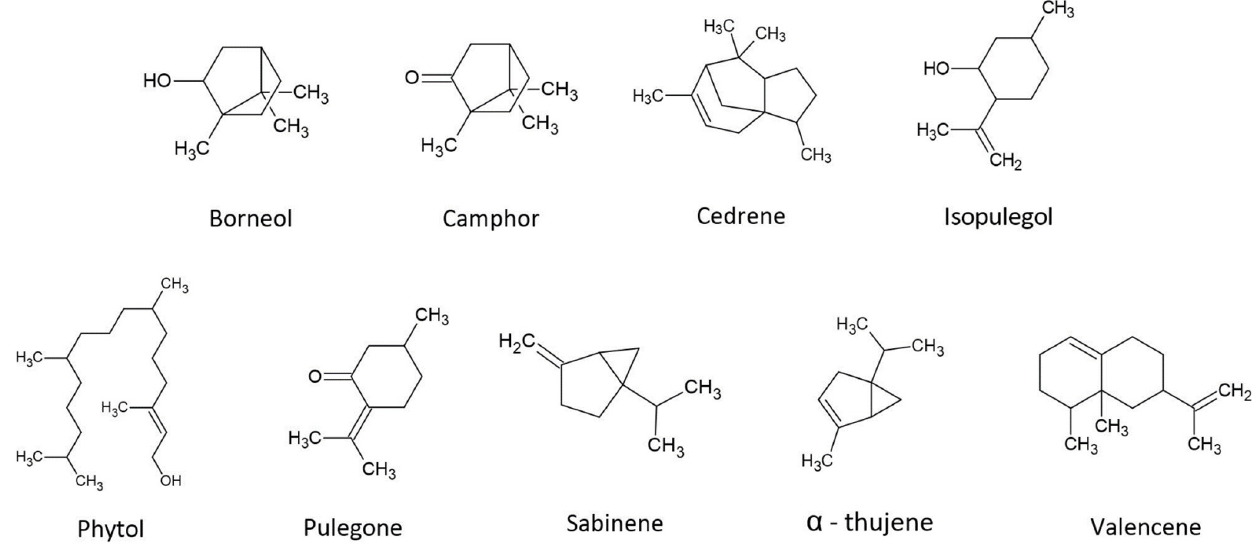
Figure 2. Structures of secondary terpenes present in Cannabis sativa